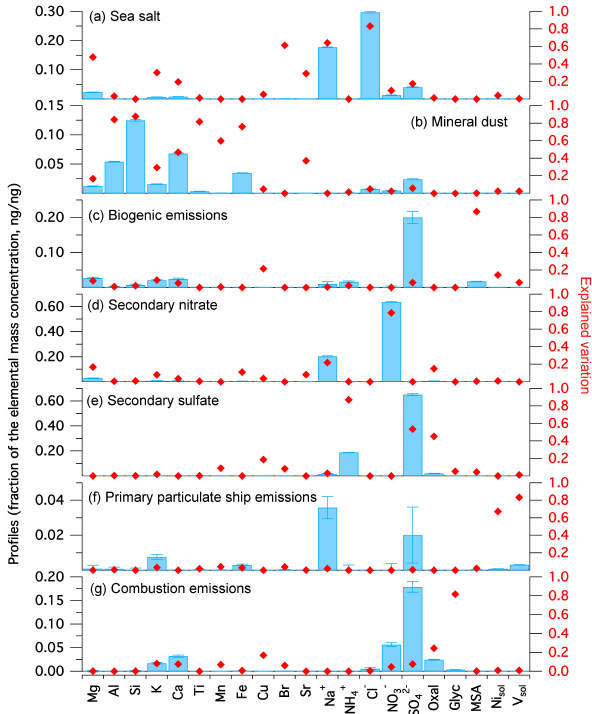
Figure 3. Profiles (fraction of the elemental mass concentration, blue columns) and explained variations (red squares, referring to the right y axis) of the identified PM 10